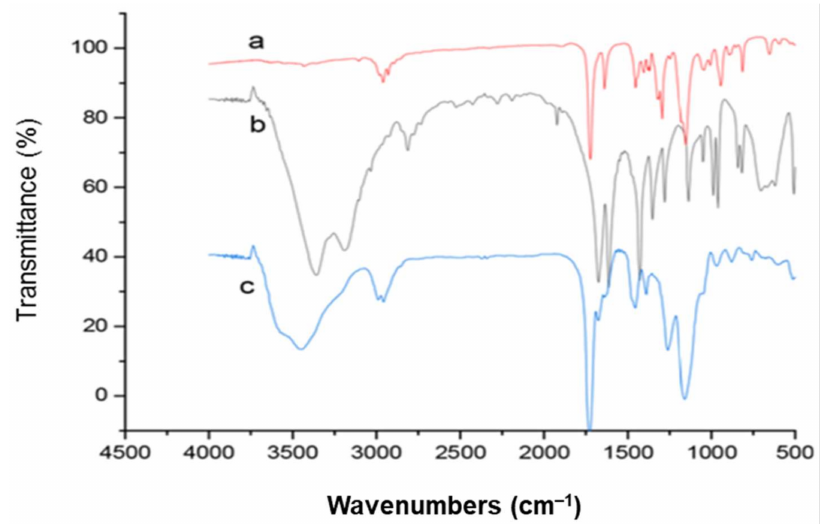
Figure 12. FT-IR spectra: ( a ) EGDMA; ( b ) AM; ( c ) MIPAM